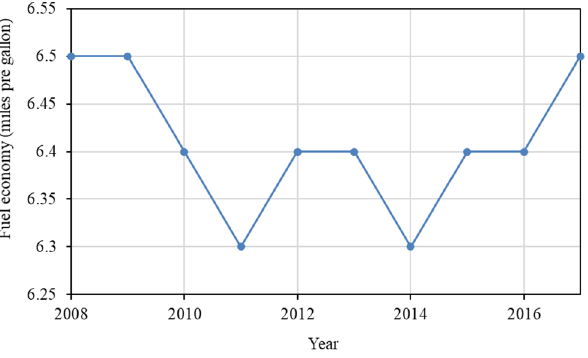
Figure 7. Fuel economy of medium- and heavy-duty vehicles in the U.S. from 2008 to 2017. Negative Factors